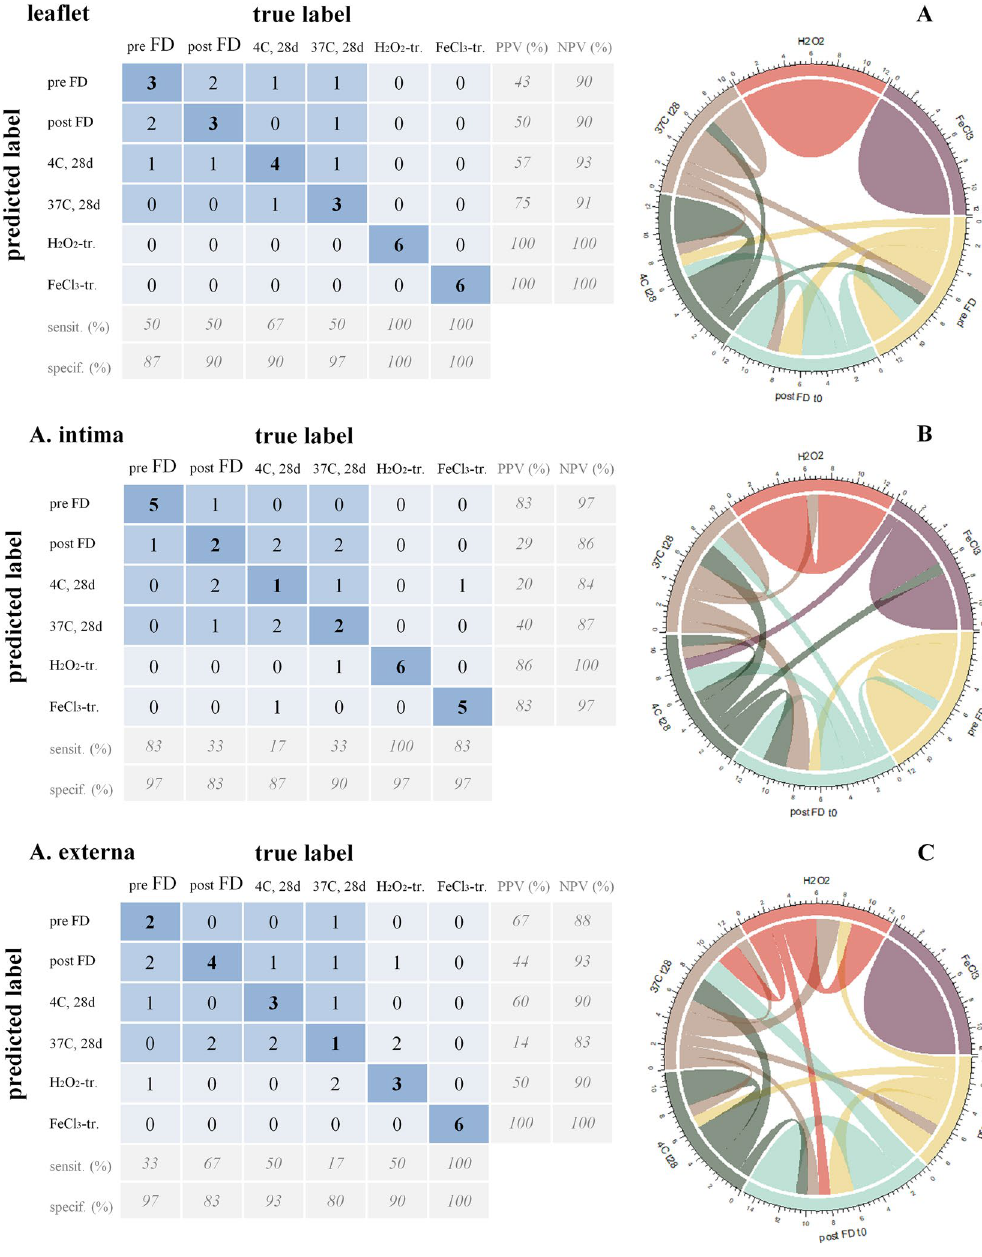
Figure 6. Application of a supervised machine learning approach, by means of a convolutional feed-forward artificial neural network (ANN) model for classification of infrared spectra obtained from decellularized heart valve tissues exposed to freeze-drying and dried storage, as well as induced oxidative stress. Analysis was done for the leaflet, artery intima, and externa layer and the results are presented as confusion matrices (left panels) and chord diagrams (right panels) to demonstrate the interrelationships between different groups. Inside the confusion matrix, discrimination indicates the number of the correctly acquired spectra in the model within each group as the true positive (TP) values. The description of the rows located on the bottom of the confusion matrix indicates the number of observations correctly identified for each predicted class as percentages defined for each group as sensitivity. The description of the rows under the sensitivity displays the proportion of negatives that are correctly identified as specificity. The description of the columns located on the left side of the confusion matrix displays the number of correctly classified observations for each true group as positive predictive value (PPV) and on the right side is negative predictive value (NPV) which means the groups that the test provided gave a negative